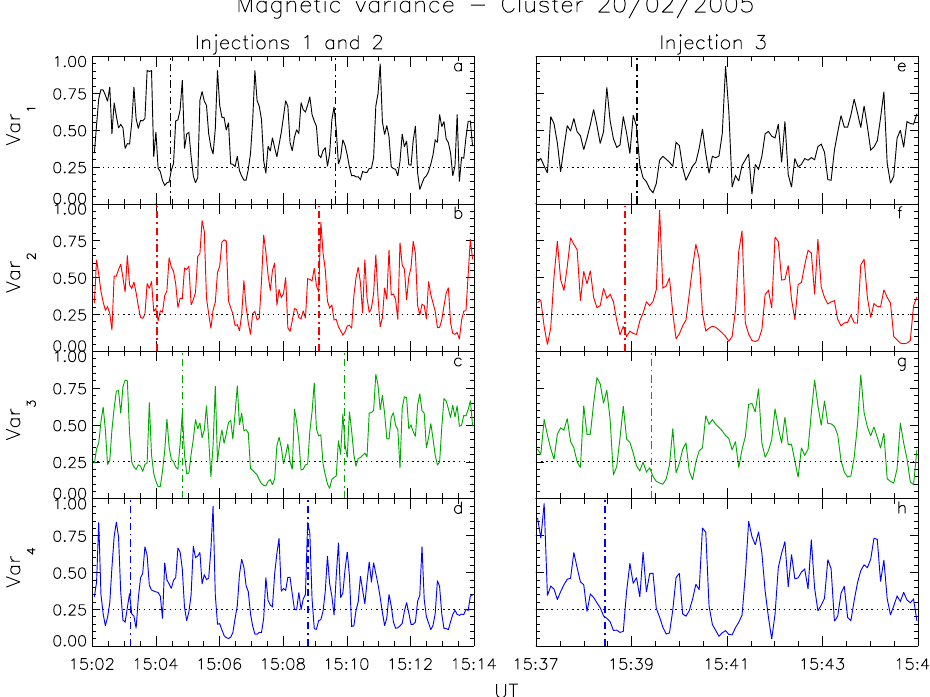
Fig. 7. FGM variance ratio between the intermediate and largest eigenvalues of the covariance matrix of the magnetic signal for each Cluster spacecraft (black line for sc-1, red for sc-2, green for sc-3 and blue for sc-4). (a) to (d) for the 15:02–15:14UT period (Injections 1 and 2). (e) to (h) for the 15:37–15:45UT period (Injection